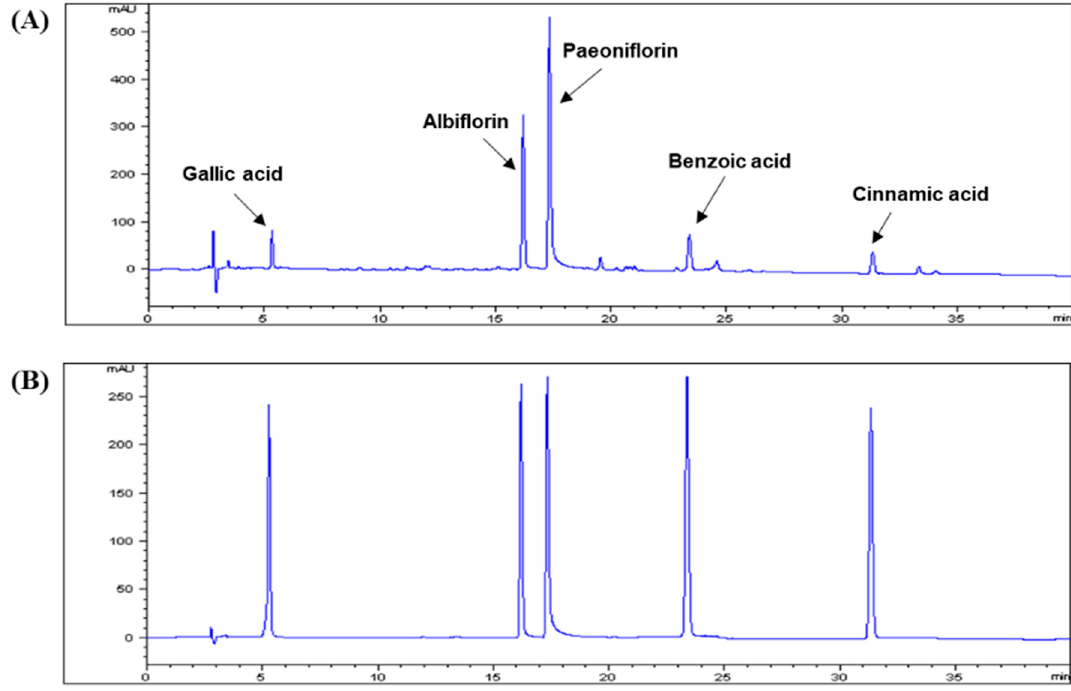
Figure 1. HPLC chromatograms of CPA4-1 (Cinnamomi Ramulus:Paeoniae Radix = 1:8) ( A ) and five standard compound mixtures ( B ). The chromatographic conditions are described in the text. Detection was conducted at 240 nm.